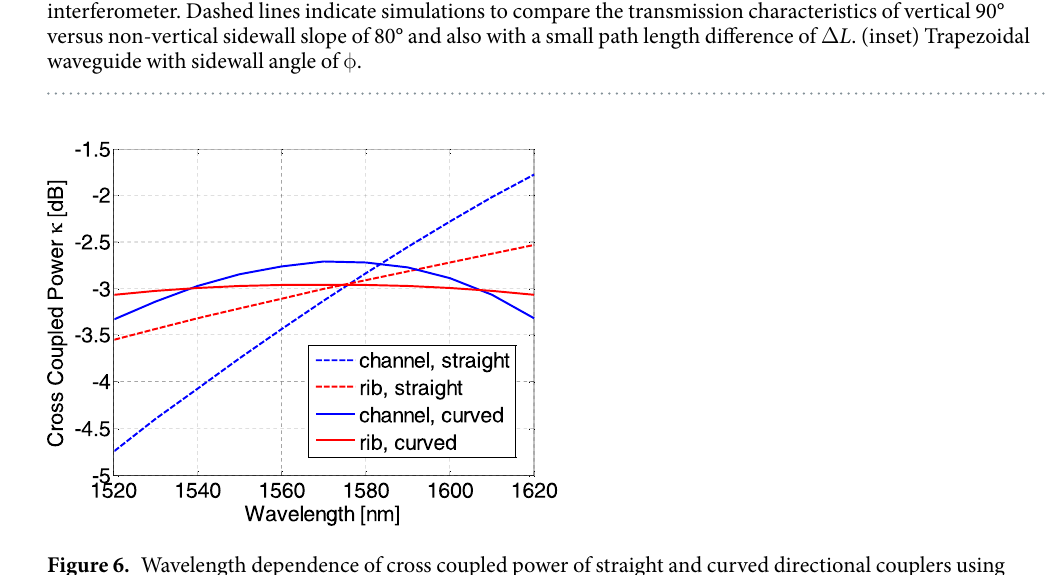
Figure 6. Wavelength dependence of cross coupled power of straight and curved directional couplers using channel and rib waveguide